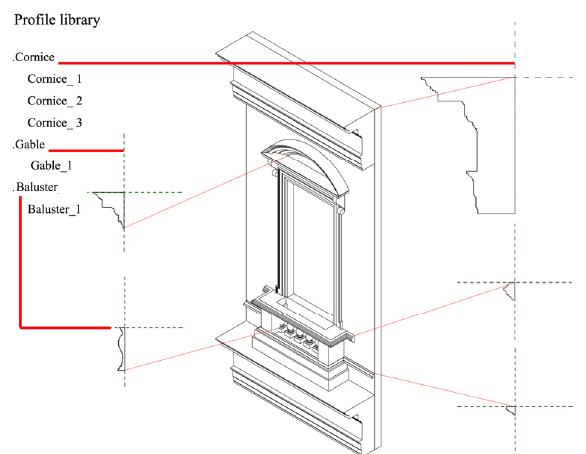
Figure 5. A unit of facade of Palazzo Barbaran da Porto and its profile